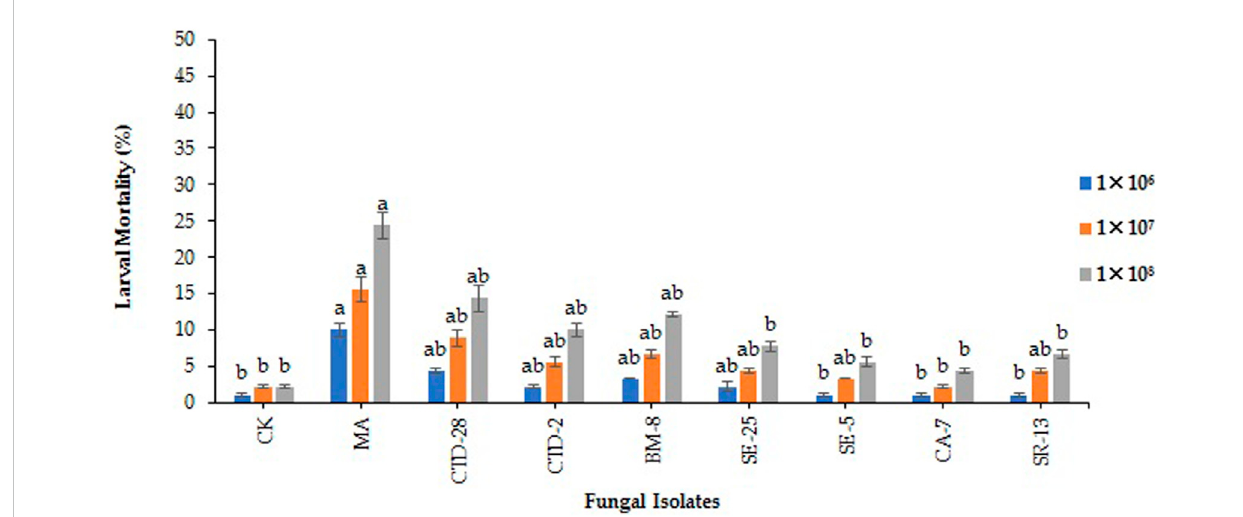
FIGURE 4 Effects of entomopathogenic fungal isolates on larval mortality of fall armyworm treated with different concentrations at 7 days post treatment. Error bars denote the mean ± standard error at the 95% con fi dence interval. Means followed by the same letters are not signi fi cantly different by Tukey ’ s test at p <